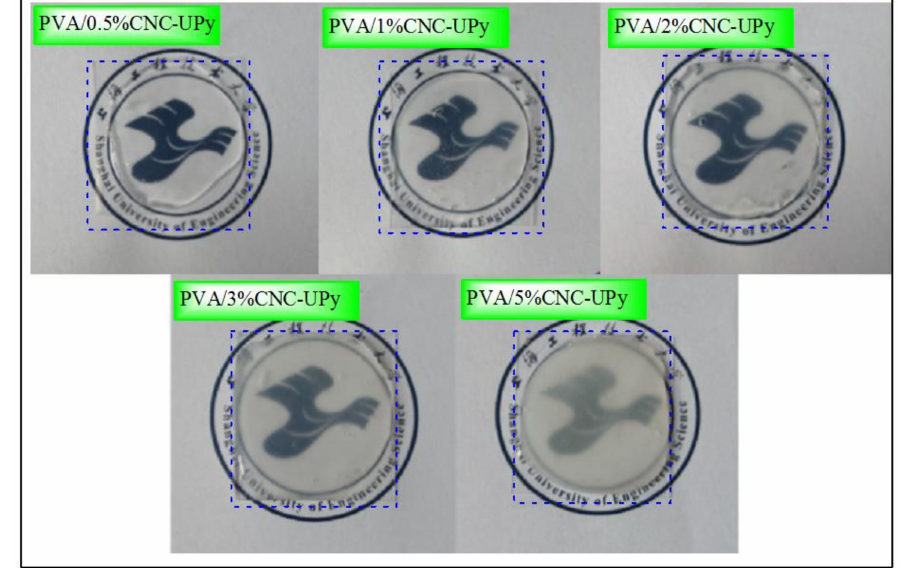
Figure 5. Photos of di ff erent PVA composite